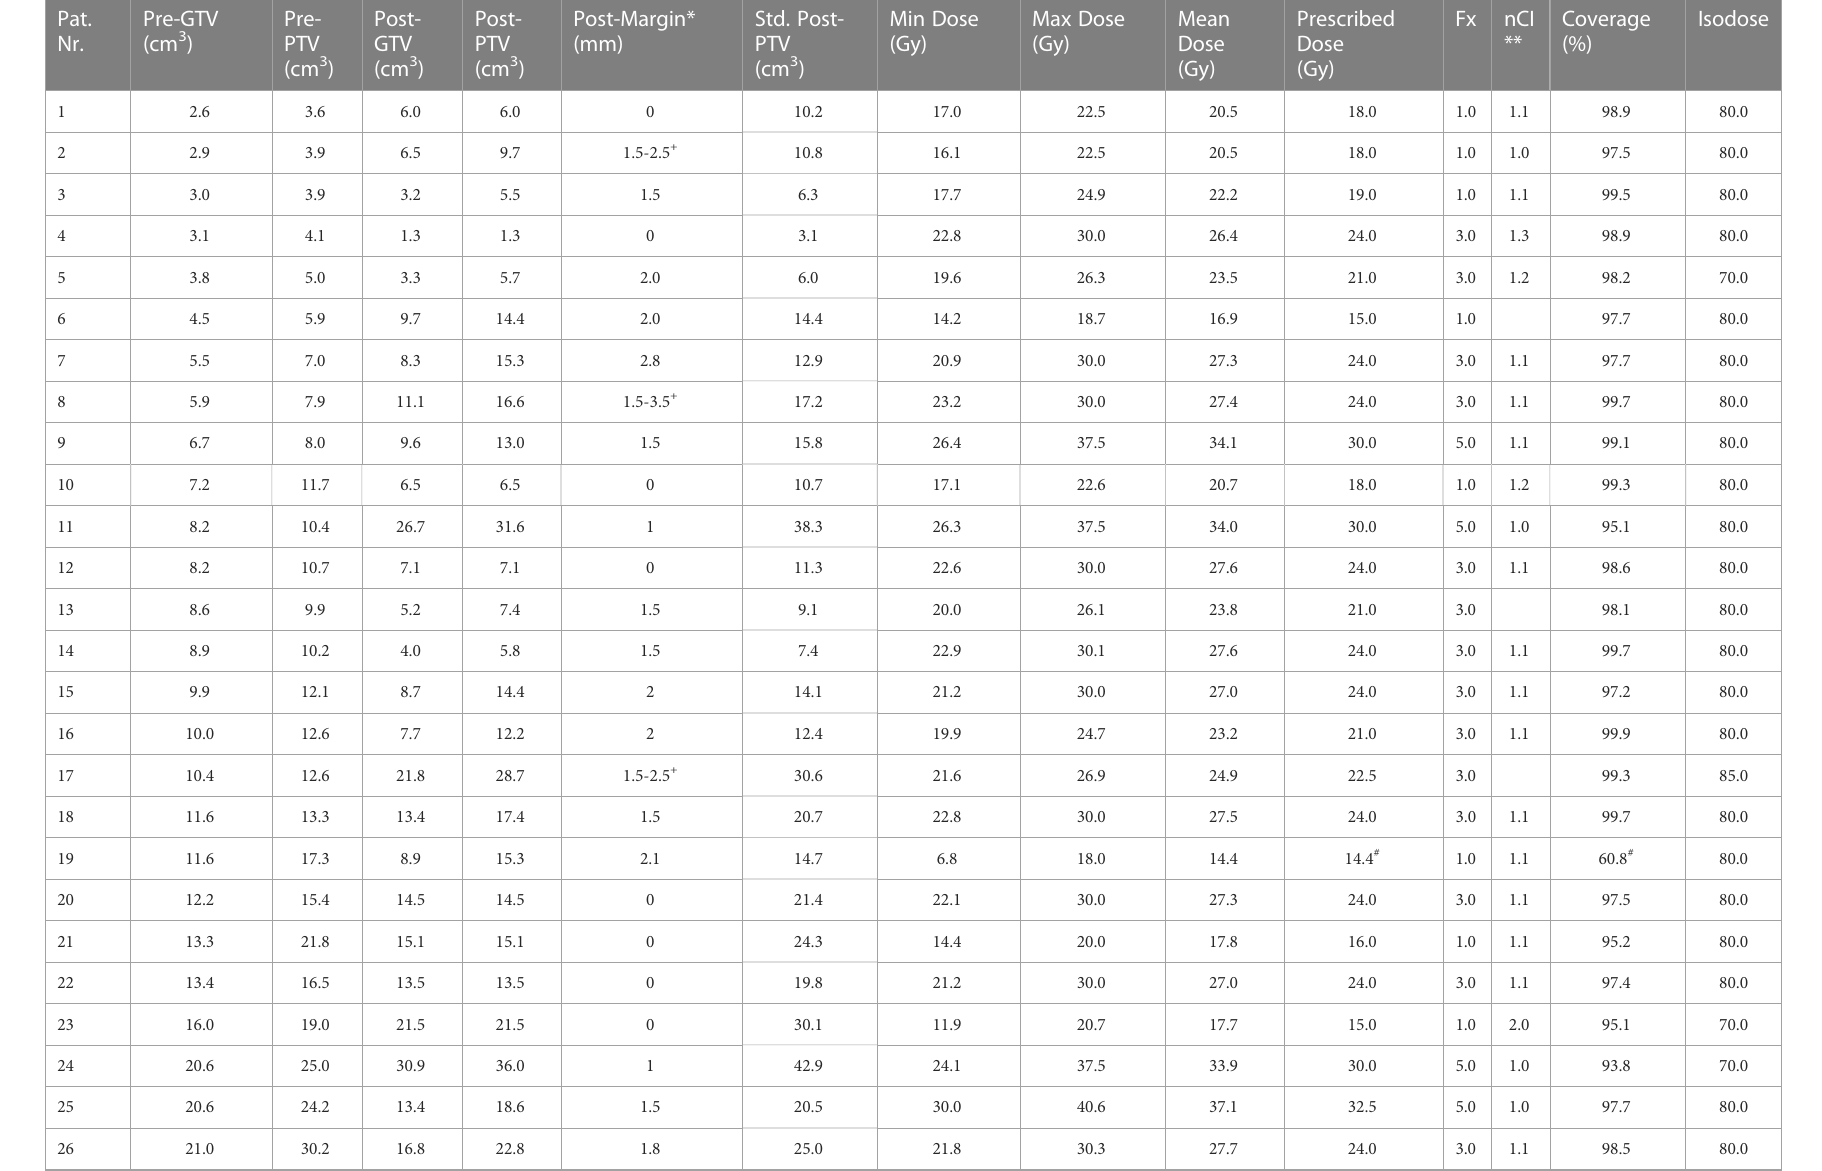
TABLE 2 Treatment characteristics of the performed resection cavity irradiation as well as gross tumor- and planning target volumes in the hypothetical planning.